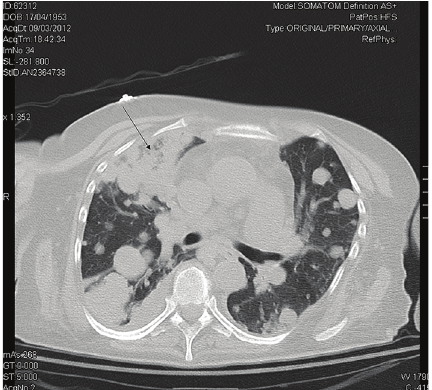
Figure 4: Lung abscess. Chest high-resolution computed tomogra- phy pulmonary angiography showing in the right upper lung lobe an area of consolidation with air inside a cavitary lesion (lung abscess probably)